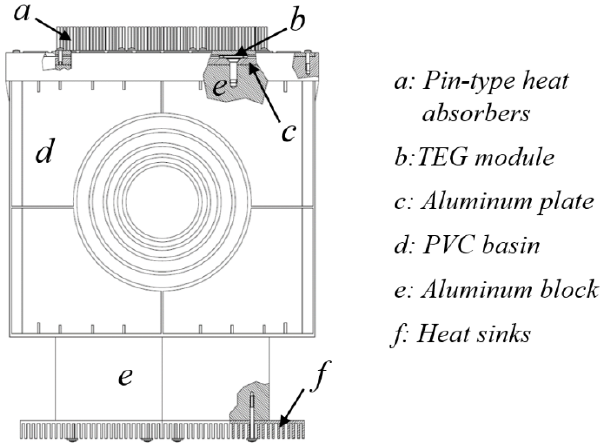
Figure 2. Schematic view of the STEG prototype used in the present study with its main components.